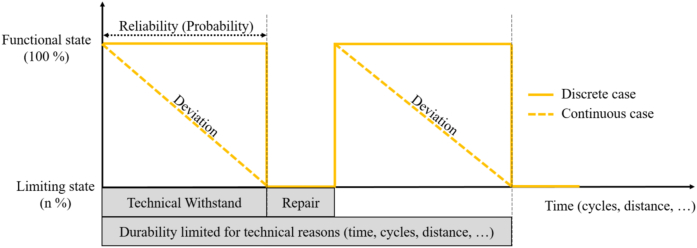
Relationship between reliability, repair and durability (adapted from EN 45552:2020).